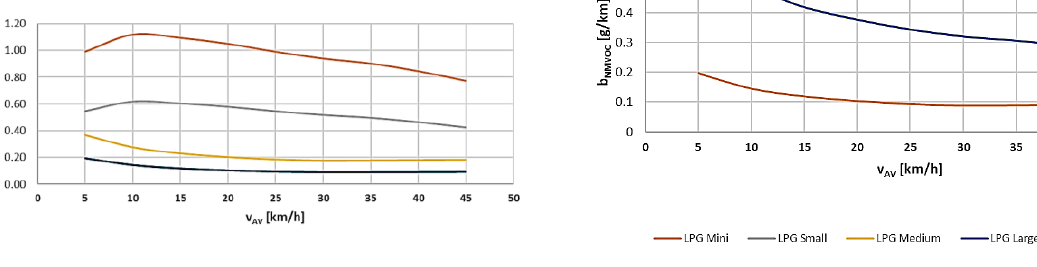
Fig. 26. NMVOC emission from LPG PCs for vehicle segments depending on average